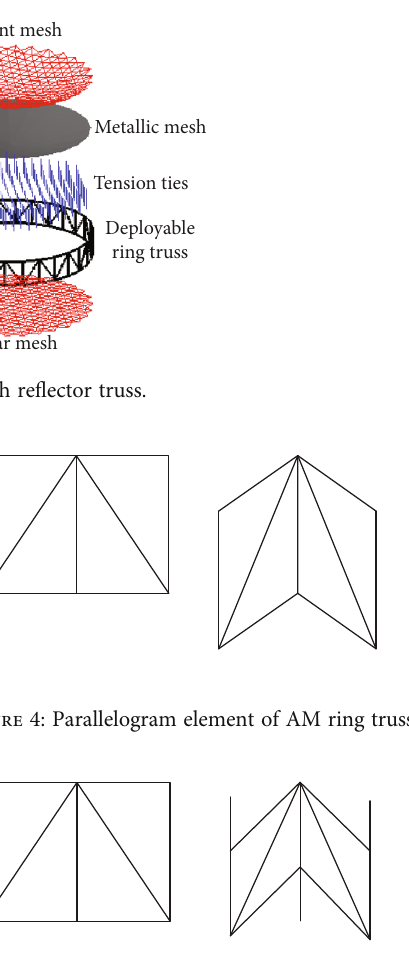
Figure 5: Parallelogram element of AM-2 ring truss structure.